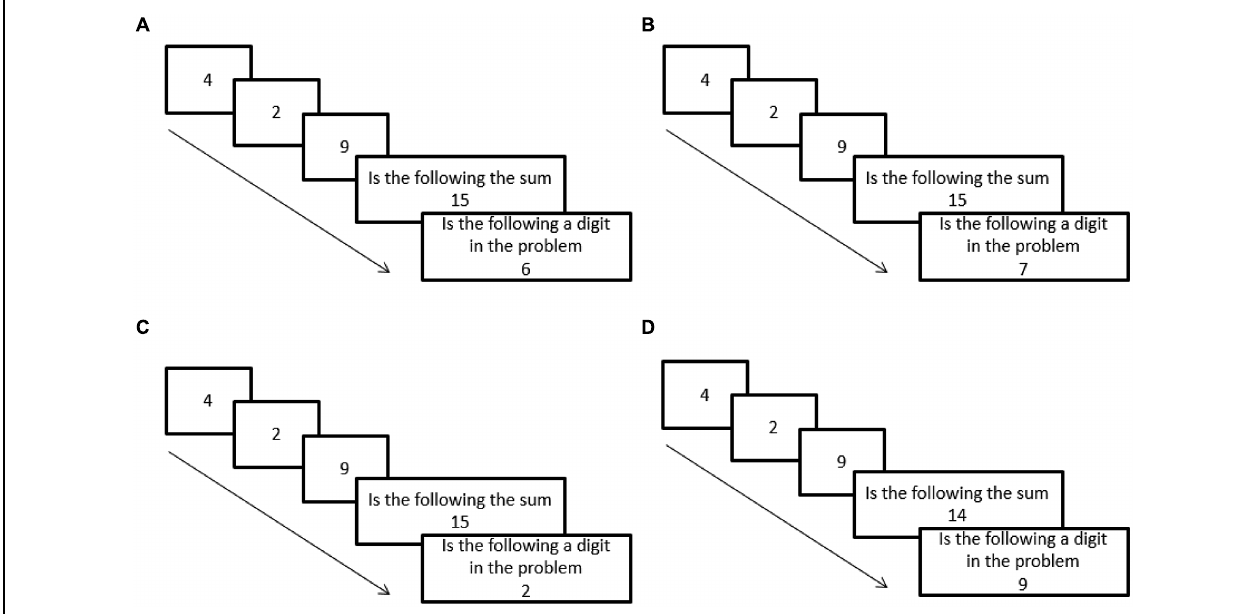
FIGURE 1 | A schematic representation of the experimental paradigm along with the various conditions are displayed. Three addends are presented one after the other and are followed by two tasks. The first task is to identify whether a specified number is the sum of the addends. The second task is to identify whether a specified digit is one of the addends of the problem. (A) Condition 1 (the absent digit is the intermediate sum). Task a: correct response: “yes,” Task b: correct response: “no.” Note that in this condition the intermediate sum (6) is the digit that one needs to identity as NOT one of the addends. (B) Condition 2 (the absent digit is a neutral digit). Task a: correct response: “yes,” Task b: correct response: “no.”. Note that in this condition a neutral digit (7) is the digit that one needs to identity as not one of the addends. (C) A filler condition. Task a: correct response: “yes,” Task b: correct response: “yes.” (D) A filler condition. Task a: